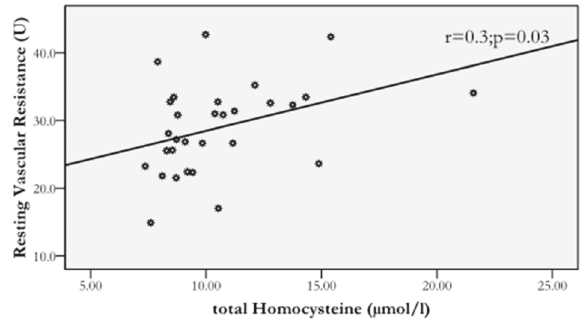
Figure 2: The relationship of homocysteine level with resting vascular resistance in the patients ( 𝑟 = −0.3 ; 𝑝 = 0.03